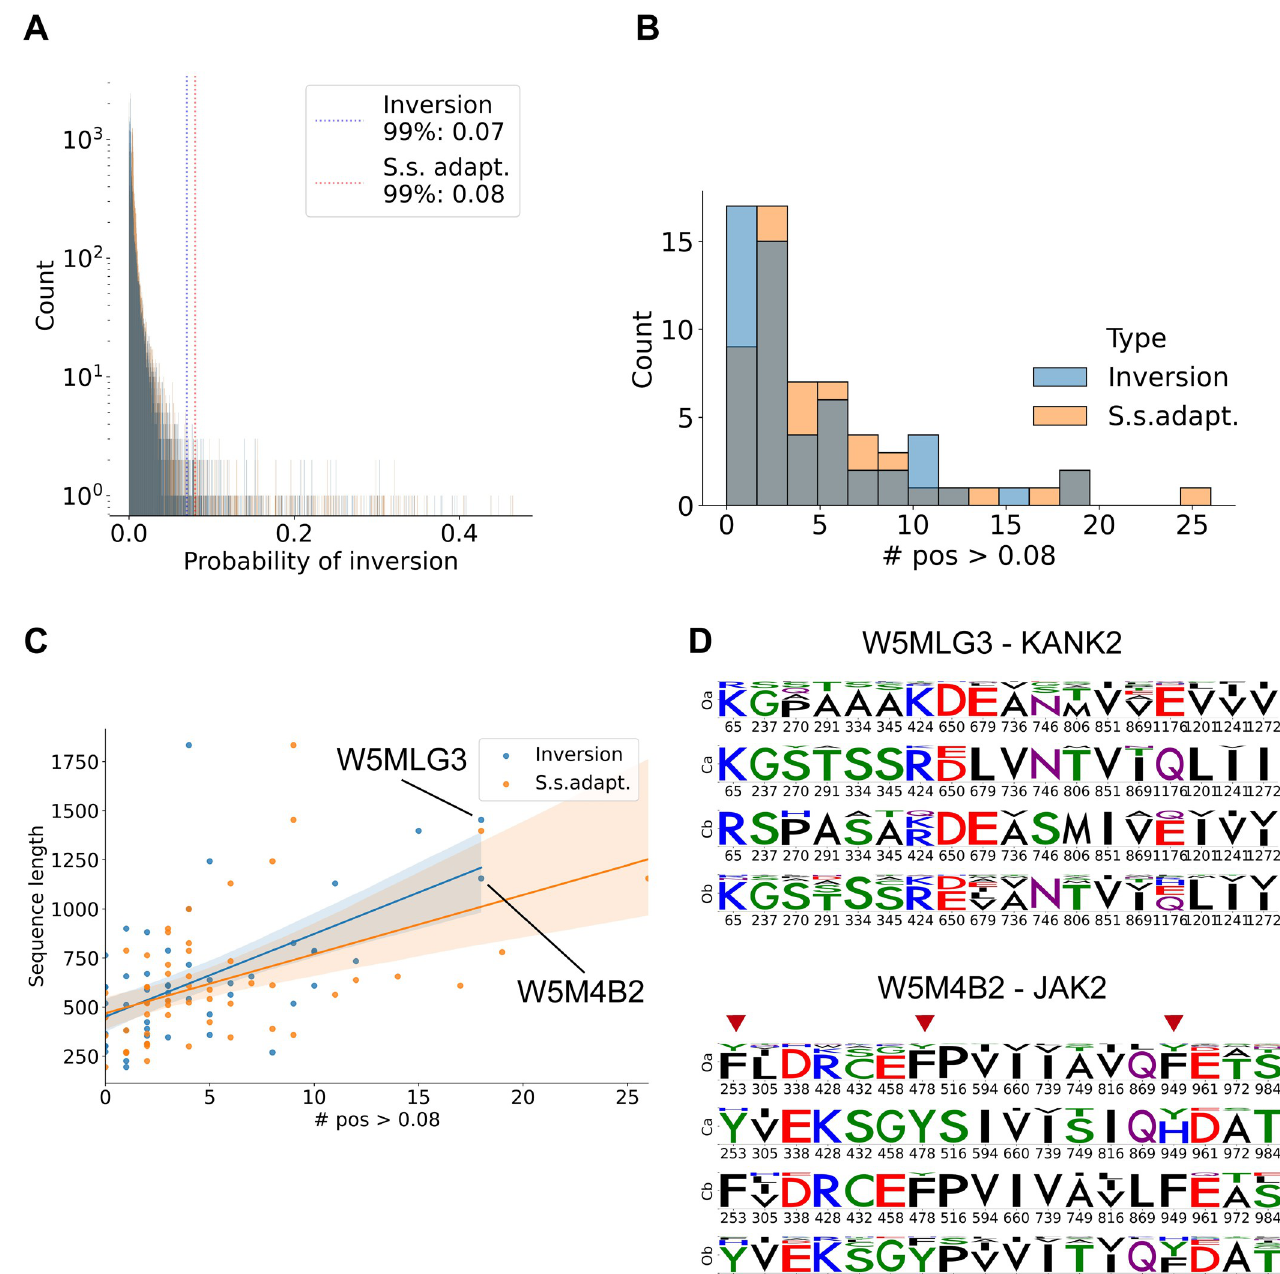
Fig 5. Extended protein dataset validation. (A) Distribution of DIRphy scores in the extended dataset. DIRphy was tested in a dataset of 54 protein duplication trees obtained from fish proteomes. The blue color indicates inter-paralog inversion scores, the orange color indicates specie-specific adaptation scores. The two lines show the 99 th percentile score of the distributions. (B) Number of positions with a score higher than 0.08 per protein. More than half of the dataset has less than 5 high scoring positions. (C) High scoring positions ( > 0.08) per protein versus protein length. The two proteins that have 18 high scoring positions in the inter-paralog inversion score are highlighted. (D) Sequence logo of the high scoring positions for the two previously highlighted proteins. The two names are respectively the spotted gar reference name and the human ortholog name. In red arrows, the positions that involve a tyrosine inversion are